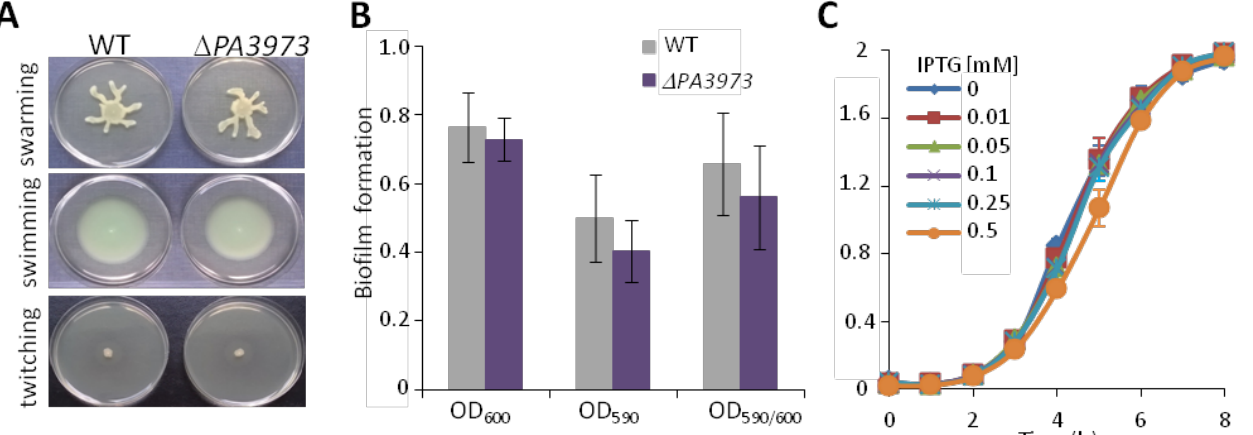
Figure 2. Phenotype analysis of P. aeruginosa PAO1161 WT, ∆ PA3973 , and PA3973 overproducer strains. ( A ) Selected pictures of swimming, swarming, and twitching analyses of WT P. aeruginosa PAO1161 and ∆ PA3973 mutant. ( B ) Biofilm formation of WT P. aeruginosa PAO1161 and ∆ PA3973 mutant. Cultures were grown without shaking in LB medium at 37 °C for 24 h and biofilm content measurements were performed. Data represent mean ± SD from 6 biological replicates. No statistically significant changes were observed by comparing Δ PA3973 with WT ( p > 0.05 in a two-sided Student t test). ( C ) Growth curves of P. aeruginosa PAO1161 cells carrying pKKB3.11 ( tac p- PA3973 ) grown under selection in LB in the presence of different concentrations of IPTG. Data represent mean ± SD from 3 biological